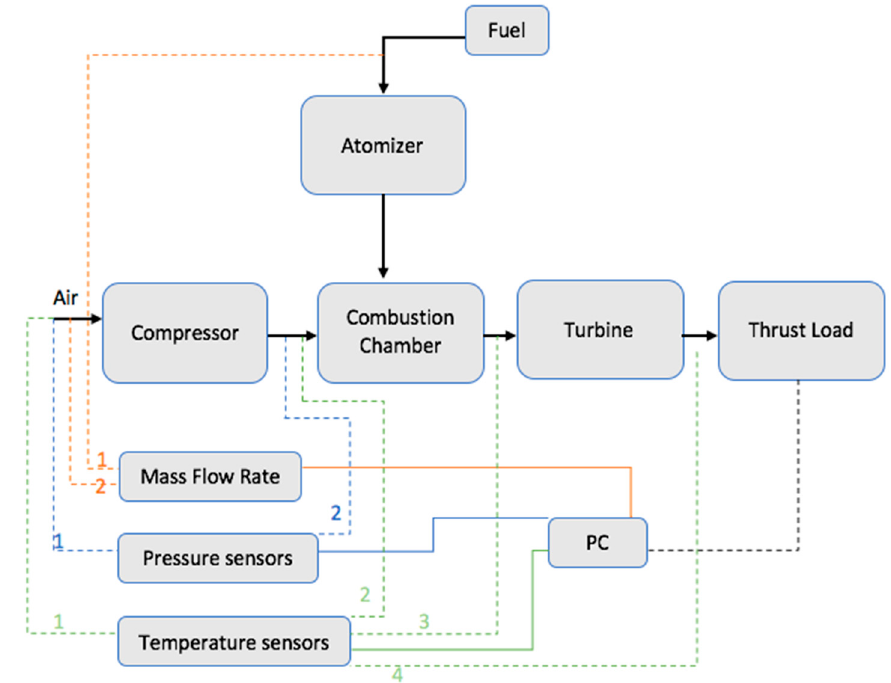
Figure 1. The block diagram of designed engine test bed.